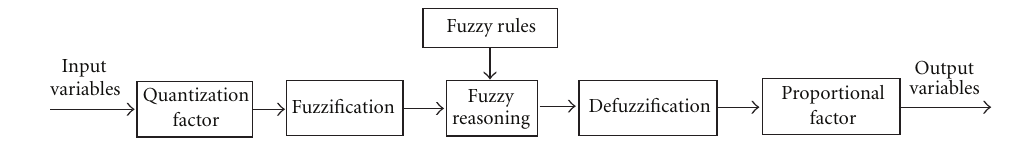
Figure 5: Basic structure of fuzzy model.